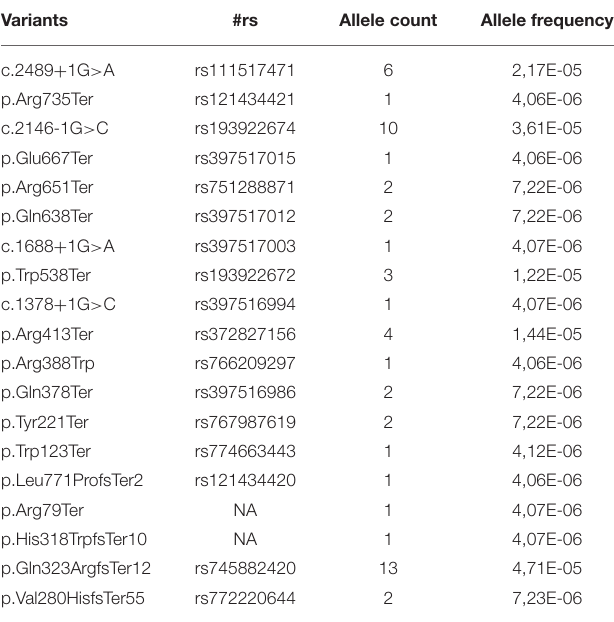
TABLE 2 | Allele frequency of the ACM-related Pathogenic/Likely Pathogenic variants reported in ClinVar according to GnomAD (both database accessed